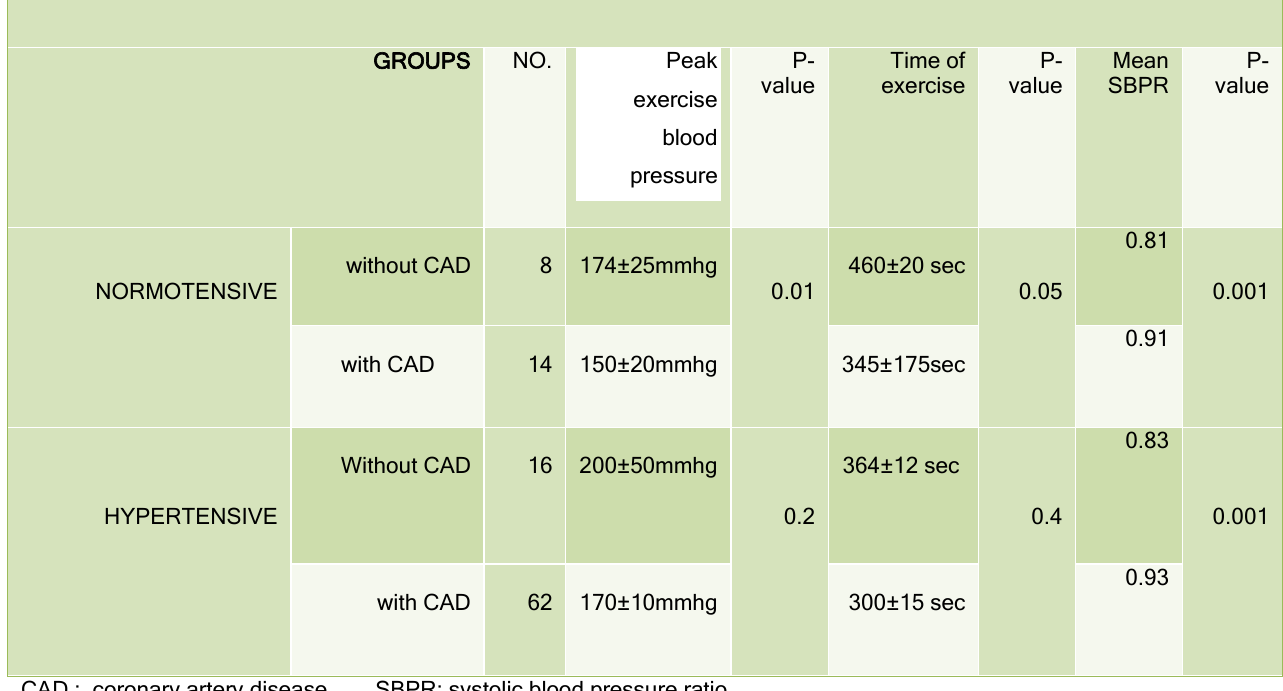
TABLE (3) results ofTMT in hypertensive and normotensive patients with CAD and without